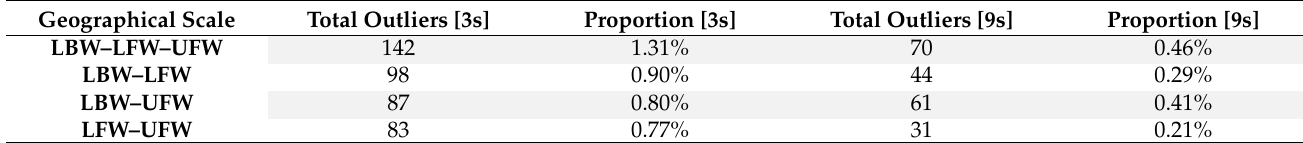
Figure 6. Proportion of outlier SNPs across the geographical scale LBW-LFW-UFW (eleven sites) detected by BayeScan v2.1 for ( A ) 10,836 SNPs in three-spined stickleback and ( B ) 15,033 SNPs in nine-spined stickleback. Table 3. Proportion of outlier SNPs on four geographical scales as detected by BayeScan v2.1 for 10,836 SNPs in three-spined stickleback ([3s]) and for 15,033 SNPs in nine-spined stickleback ([9s]). LFW: lowland freshwater, LBW: lowland brackish water, and UFW: upland